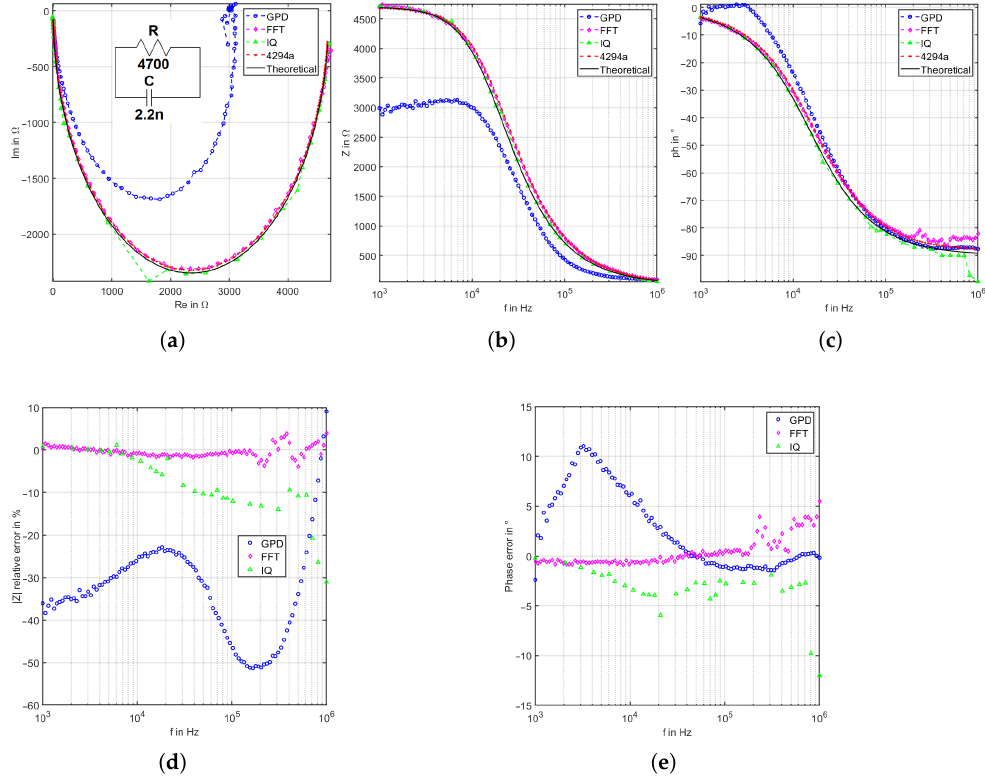
Figure 9. Results for the RC element (4.7 k Ω and 2.2 nF): ( a ) Nyquist plot, ( b ) magnitude bode plot, ( c ) phase bode plot, ( d ) magnitude relative deviation, and ( e ) phase relative